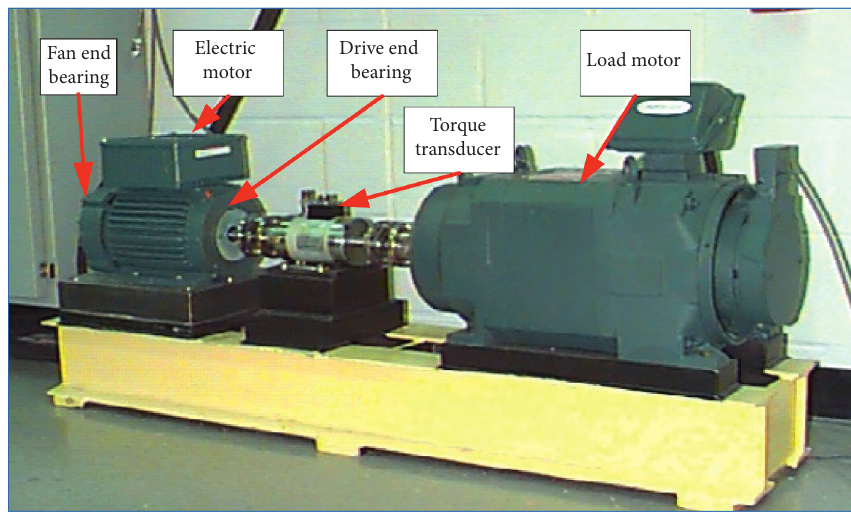
Figure 4: Fault simulation test rig of the CWRU data set.